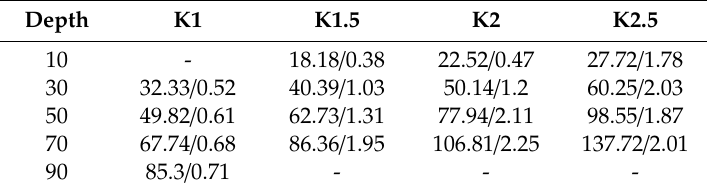
Table 4. Propagation time in Experiment 3 (EXP3) (mean / standard deviation), µ s.